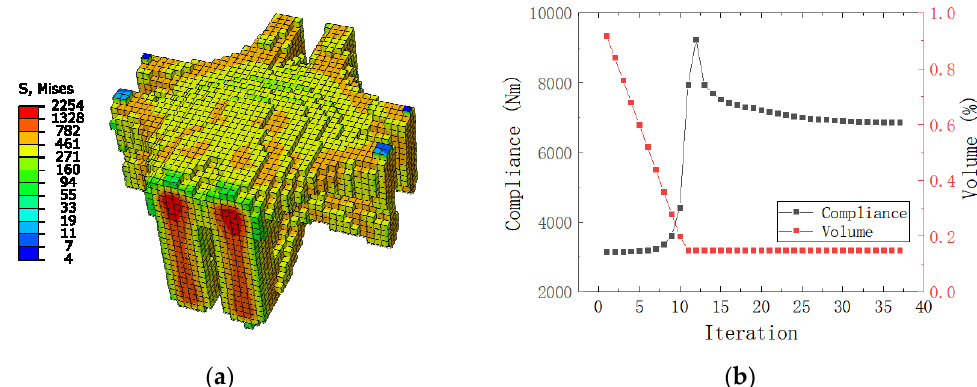
Figure 7. Isotropic topology optimization results: ( a ) stress contour; ( b ) iterative curve. Therefore, the BESO secondary development procedure was reasonably reliable.